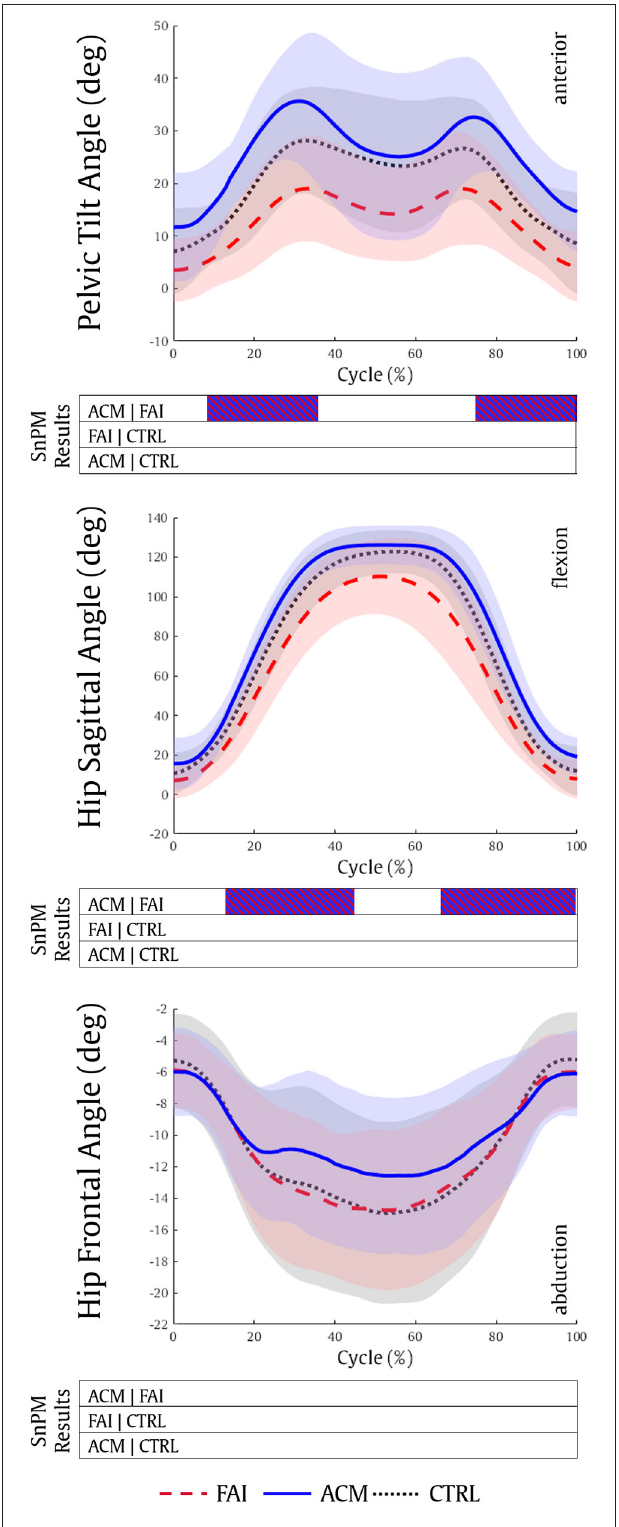
FIGURE 1 | Pelvic tilt, hip sagittal, and hip frontal kinematics during the squatting task for the FAI (dashed red), ACM (solid blue), and CTRL (dotted